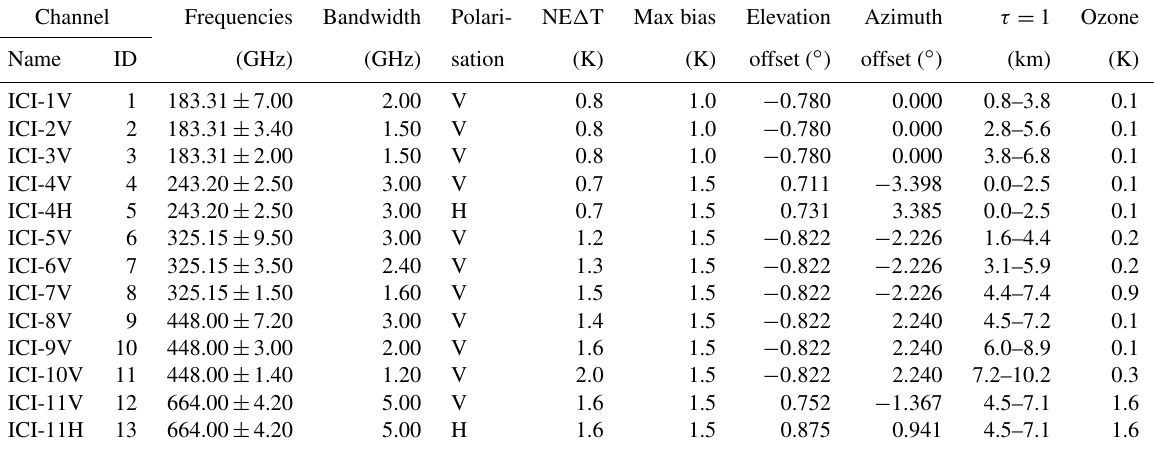
Table 1. Specifications of the ICI receiver. ICI has double sideband receivers, indicated by ± in the third column, and the bandwidth refers to the width of single passbands, i.e. the intermediate frequency bandwidth. “NE (cid:49) T” and “Max bias” are reported as the requirements, and final performance should be better. Further comments are found in the text (the last two columns are discussed in Sect. 3).